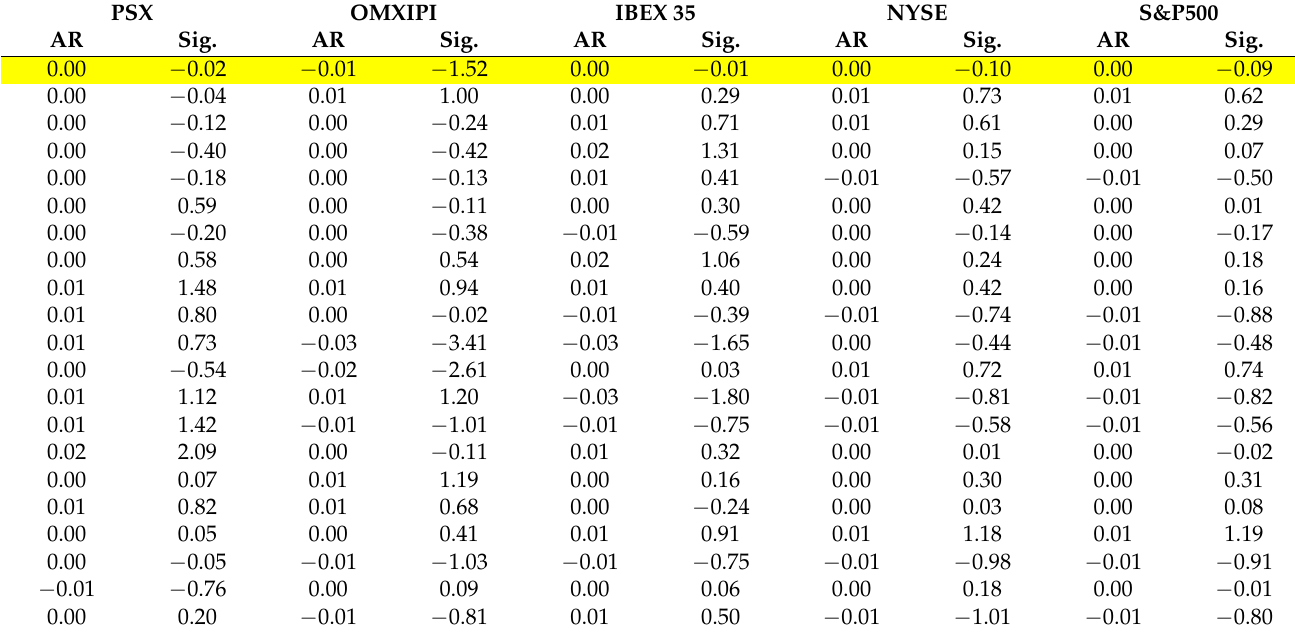
Table A32. Abnormal returns of the (0, +20) event window (Resignation of D. Jos é Manuel Soria, Spain’s Minister of